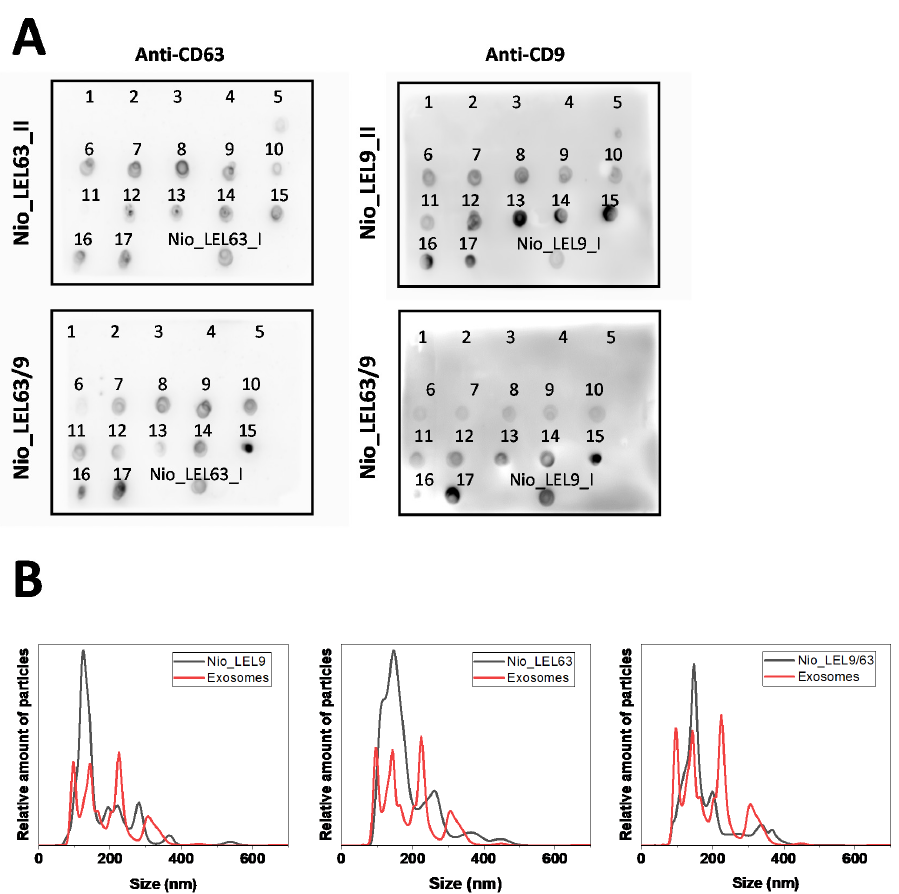
Figure 3. ( A ) Dot-blot assays for the revelation of large extracellular loops (LELs), CD9 or CD63, positive fractions collected from a Sepharose CL-2B gravity elution SEC column. Mono- and